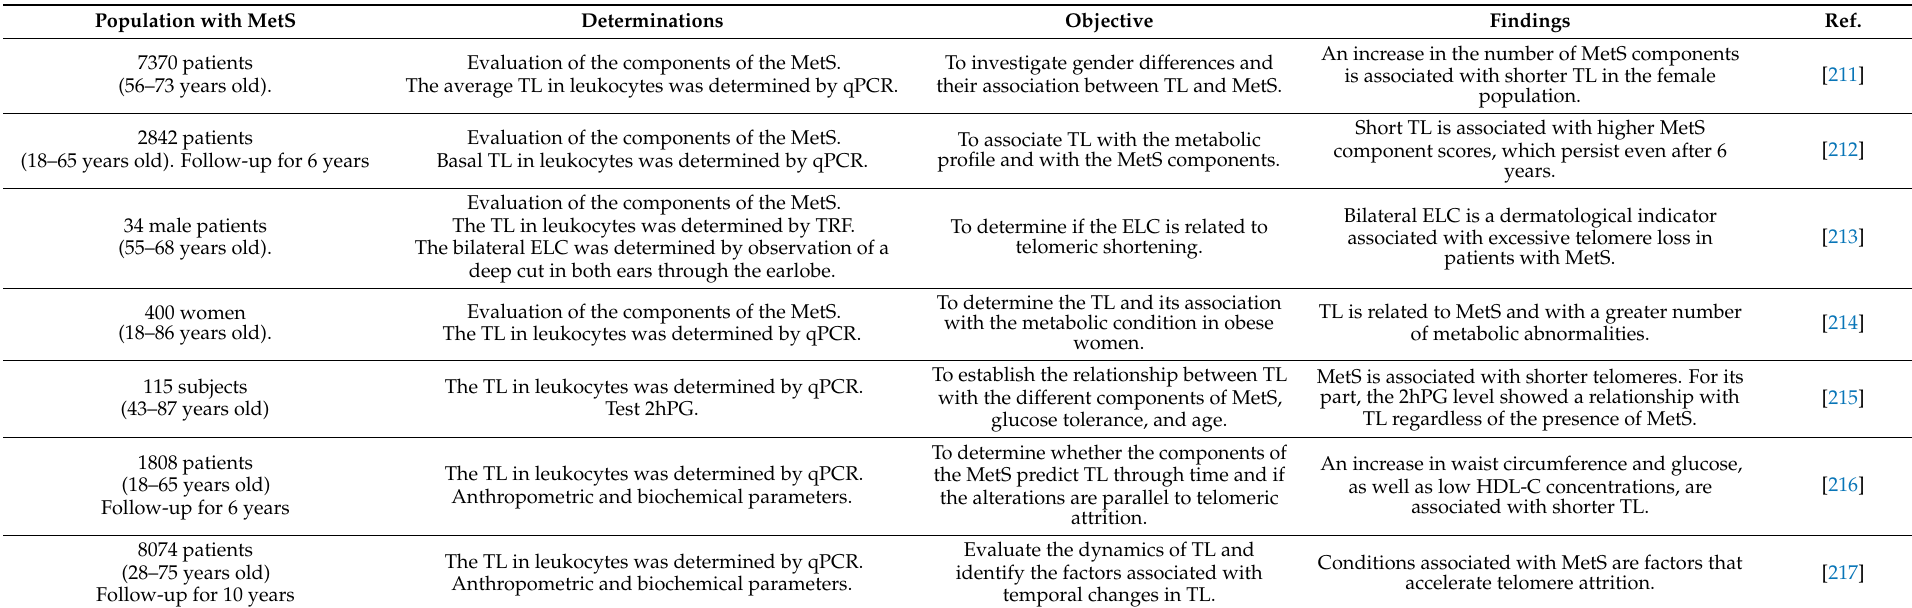
Table 1. MetS and its association with telomere